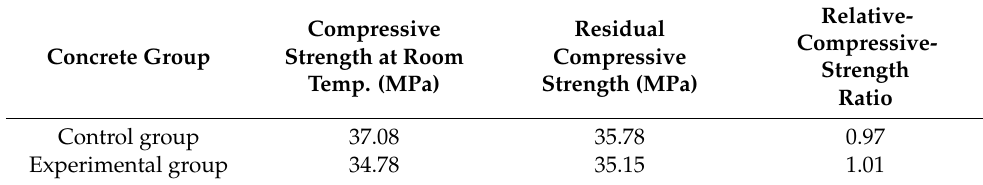
Table 12. Relative-compressive-strength ratio of the concrete after exposure to high